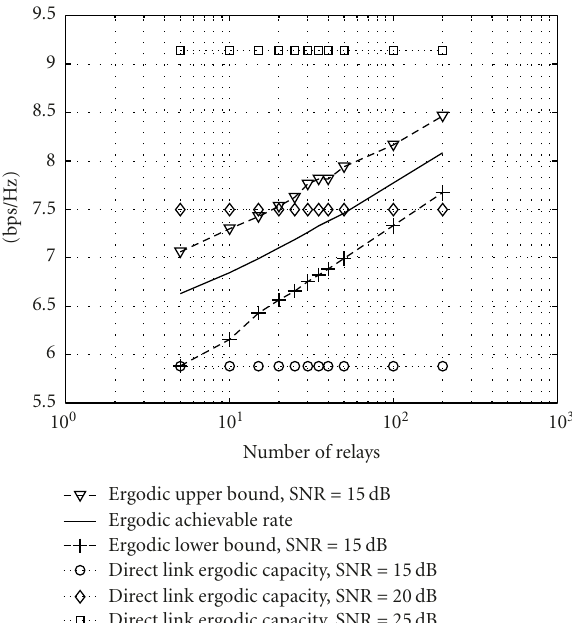
Figure 5: Ergodic achievable rate in [bps/Hz] of a Gaussian multi- ple relay channel with transmit SNR = 15dB, under Rayleigh fad- ing. The upper and lower bounds proposed in the paper are shown, and the ergodic capacity of a direct link plotted as reference.